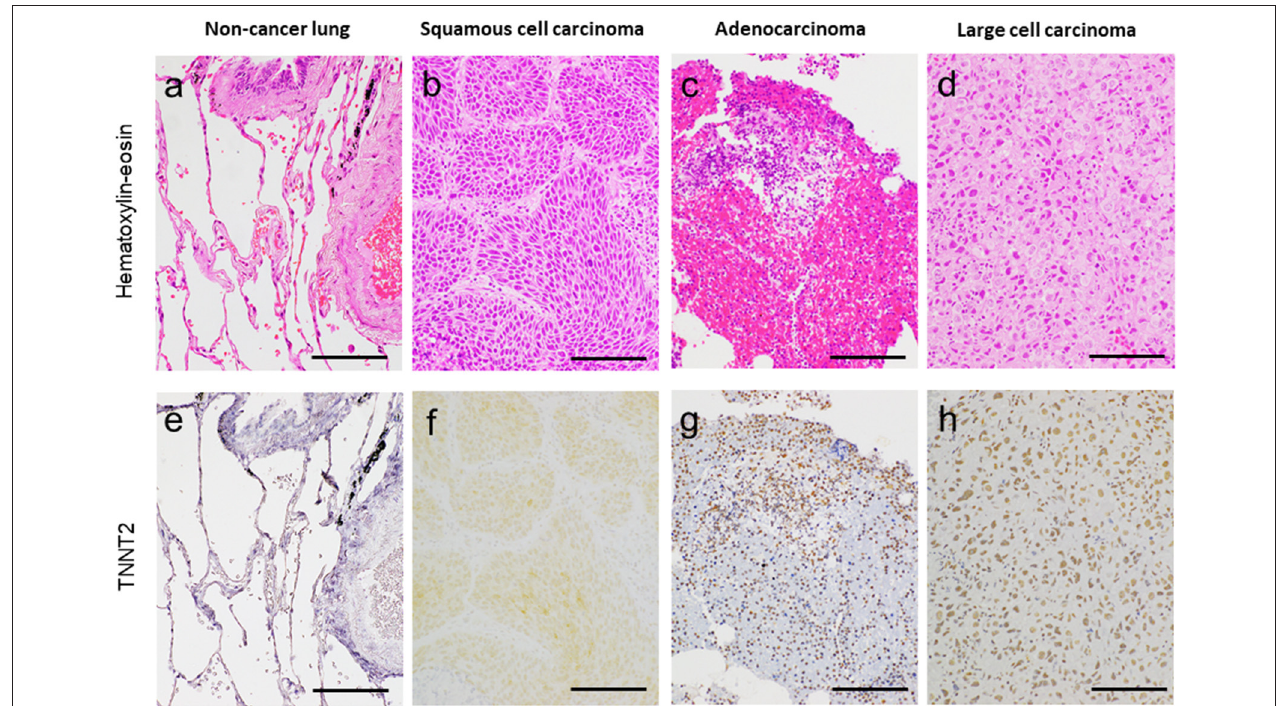
FIGURE 1 | Representative pictures for hematoxylin–eosin (a–d) and cardiac troponin-T ( TNNT2 ) (e–h) in non-cancer lung adjacent to cancer, lung squamous cell carcinoma, adenocarcinoma, and large cell carcinoma. Bar, 100 µ